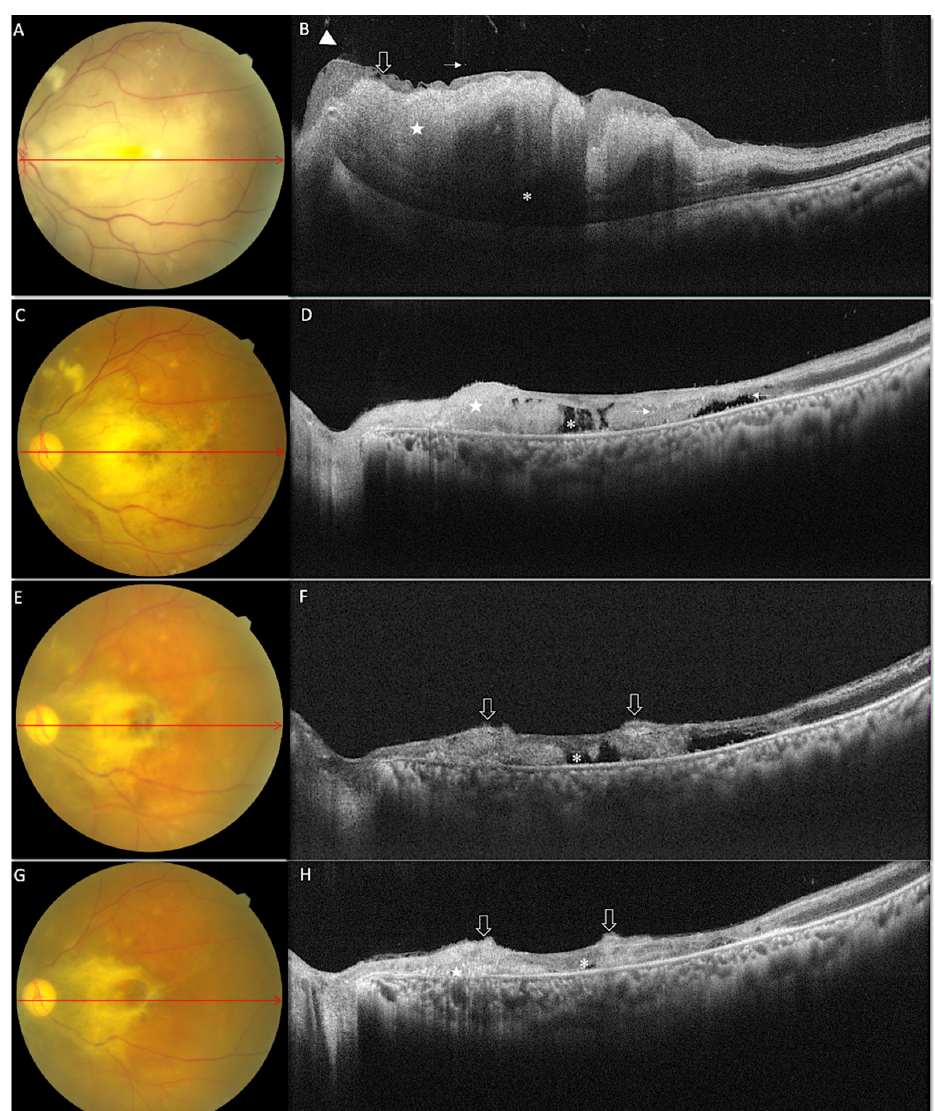
Figure 1. Serial fundus photographs and SD-OCT images of a representative case (case 5), at baseline ( A ) Fundus photographs showing diffuse retinal whiting with papilla-macular fold, boxcar segmentation of the vessel, absence of cherry red spot ( B ) The corresponding SD-OCT line scan shows diffuse retinal thickening, increased inner retinal hyperreflectivity (white star) with shadowing effect on the outer retina (white asterisk). Along with these retinal folds, inner limiting membrane (ILM) detachment (empty arrow), vitreous haze and vitreous cells (arrowhead) are also seen. At three weeks ( C ) fundus photographs show a reduction in the area of diffuse retinal whiting, with few cotton wool spots and few hemorrhages. ( D ) On SD-OCT disruption of all retinal layers (white star) along with optically empty spaces (white asterisk) (necrotic spaces) and hyperreflective foci (arrow head) with disruption of the photoreceptor layer and external limiting membrane. At four weeks ( E ) On fundus images, further reduction in the area of retinal whiting was observed with fibrous proliferation around the fovea. ( F ) OCT shows thinning of the retina with the collapse of optically empty spaces (white asterisk) along with a contraction of the inner retinal layer, clumping and baring of the outer retina in the para-foveal region (empty arrow). At end of eight weeks, there was ( G ) persistence of retinal whiting and fibrous proliferation on fundus photograph ( H ) with SD-OCT showing near-total collapse of optically empty spaces and a further thinning of the disorganized retina (white asterisk) (retinal atrophy). This accompanied disruption of ELM and photoreceptor layer.